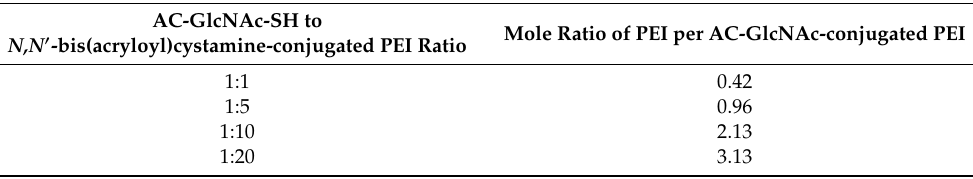
Table 1. The amount of polyethyleneimine (PEI) per polyacrylate (AC)-N-acetylglucosamine (GlcNAc)-conjugated PEIs.